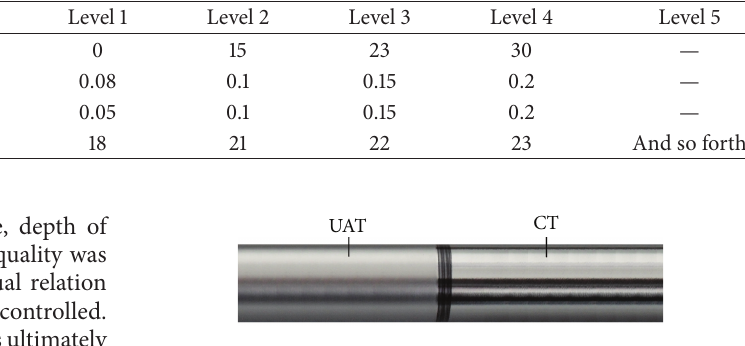
Figure 11: Differences of the machined surface between UAT and